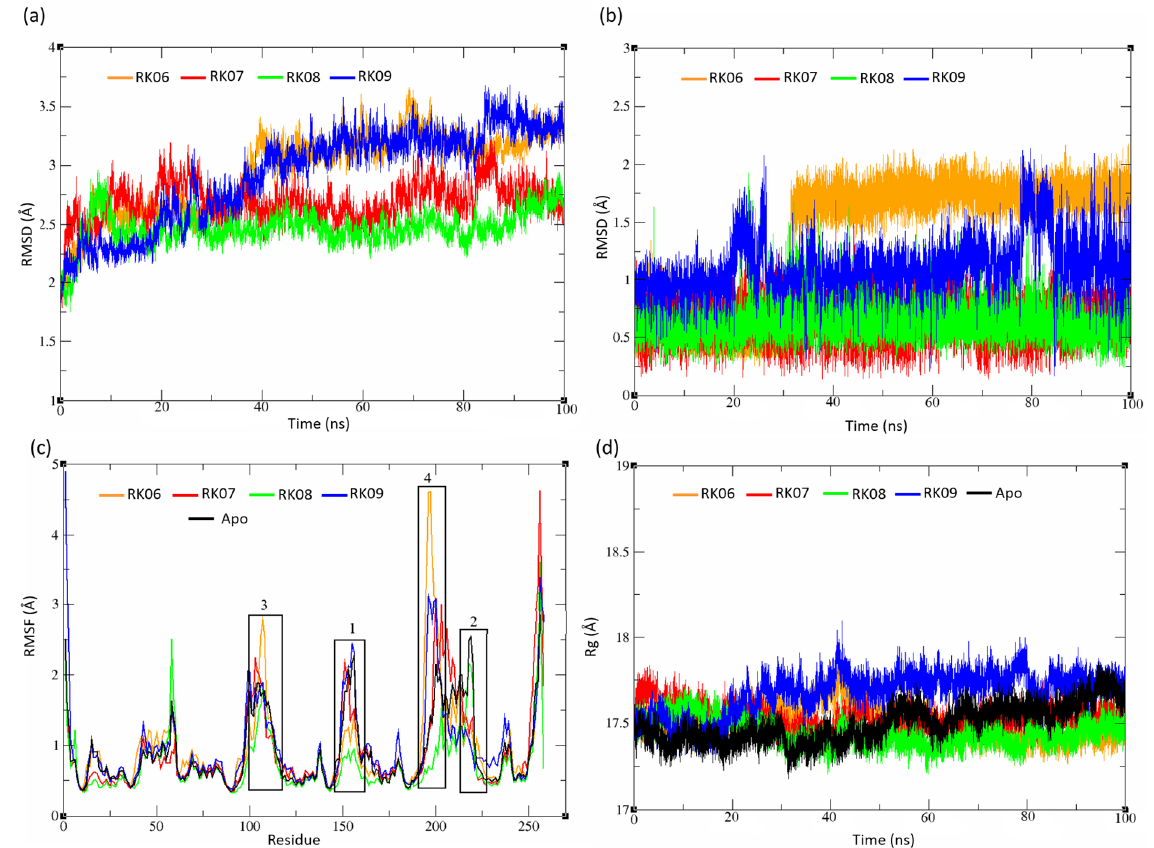
Figure 6. Substituted Diphenylmethane set analysis. ( a ) Complex RMSD, ( b ) ligand RMSD, ( c ) back- bone RMSF and ( d ) the radius of gyration. RK06 and RK09 showed less stable systems compared to RK07 and RK08. All systems demonstrated almost the same protein compactness.